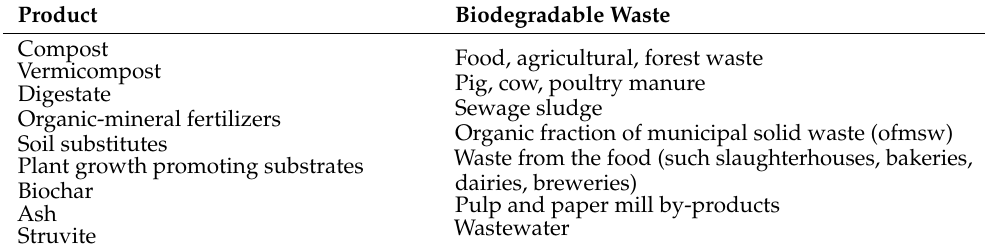
Table 1. The most frequently used biodegradable waste and products for degraded soils